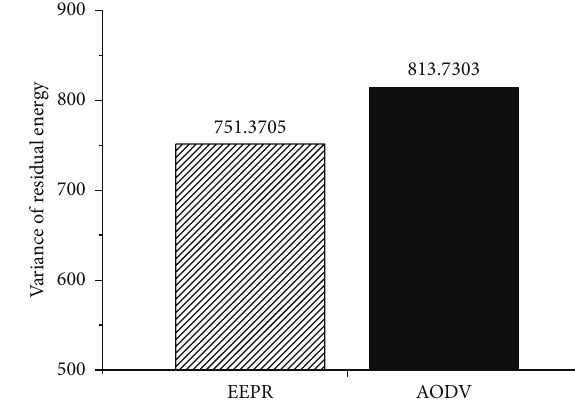
Figure 7: Variance of the residual energy.